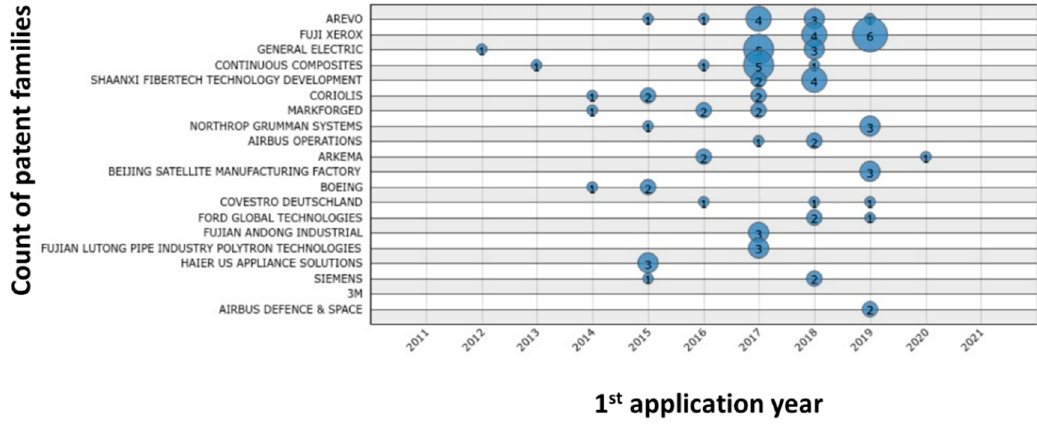
Figure 14. Count of patent families over the last 10 years for the 20 most active private assignees in FFF adapted to CFRTPC printing in February 2021.